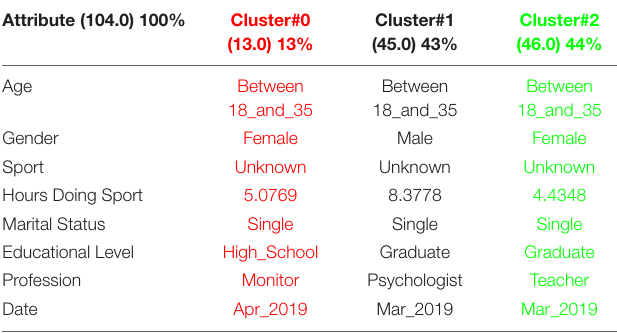
TABLE 11 | 3 clusters MBI analysis for March to May 2019.